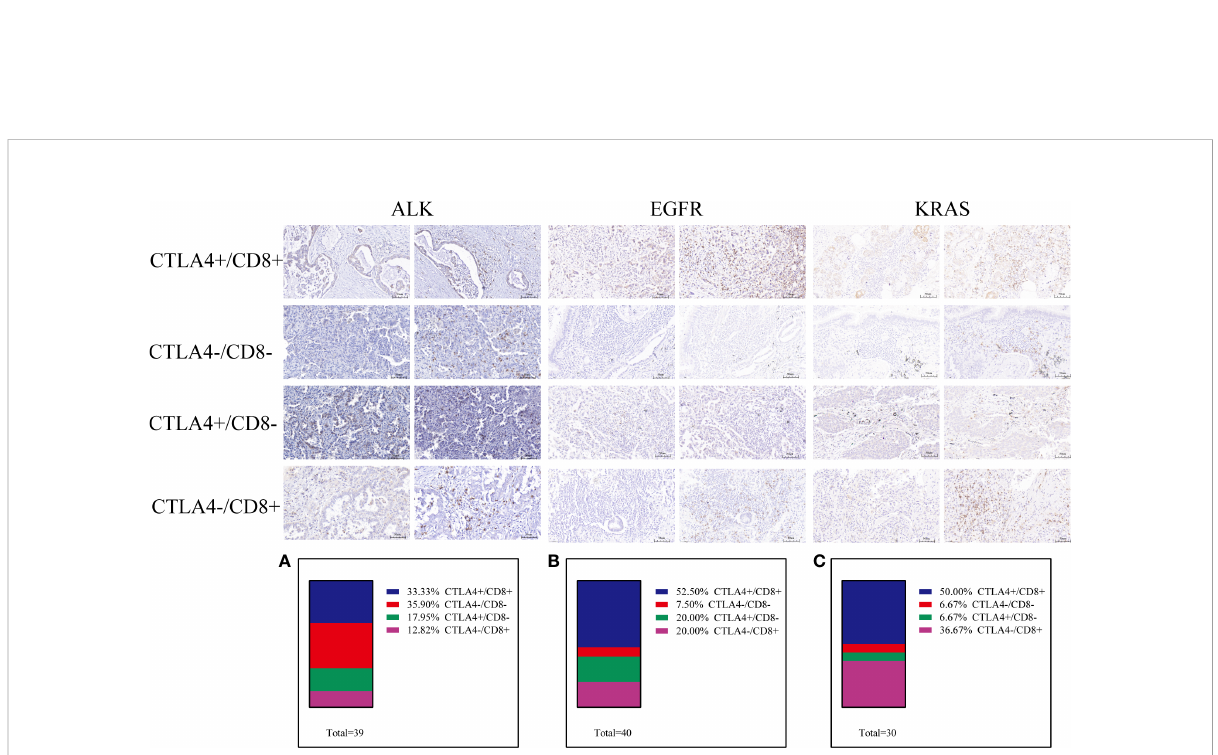
FIGURE 6 Differential proportion of CTLA4+/CD8+, CTLA4-/CD8-, CTLA4+/CD8- and CTLA4-/CD8+ in ALK-positive (A) , EGFR-positive (B) and KRAS- positive (C) NSCLC. Low (-) and high expression